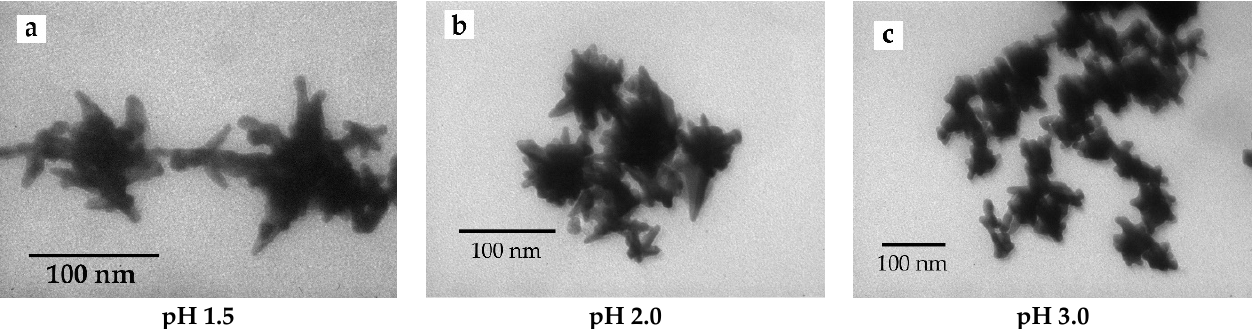
Figure 4. TEM images of GNS prepared in different pH: ( a ) 1.5, ( b ) 2.0, and ( c ) 3.0. Table 3. The influence of pH to surface plasmon resonance and intensity absorbance.